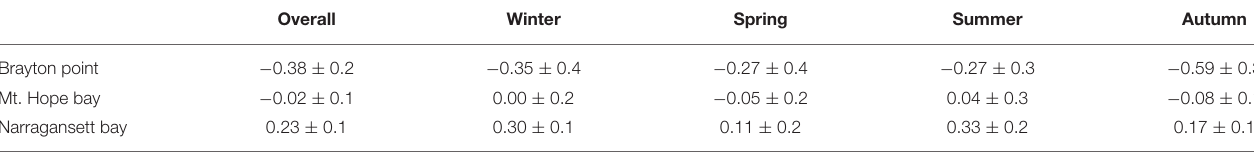
TABLE 3 | Interannual surface temperature trends in ◦ C/decade over the observational period for different Narragansett Bay regions over different seasons. Overall Winter Spring Summer Autumn Brayton